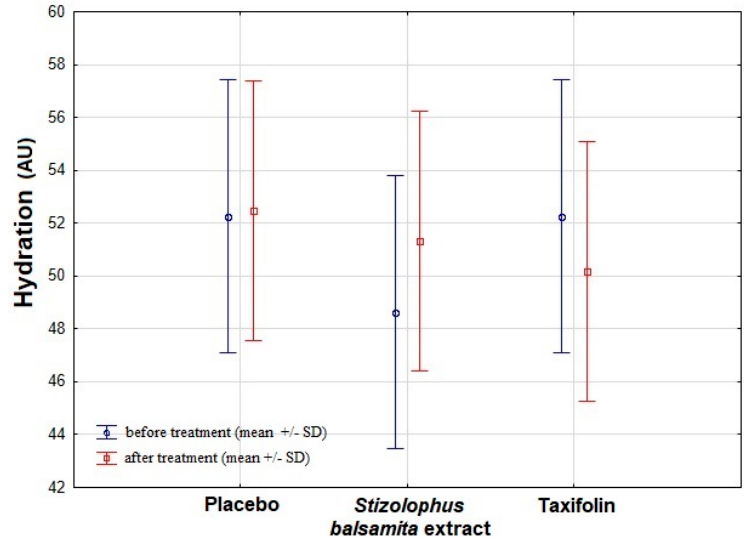
Figure 4. The comparison of skin hydration results between the examined groups. The results are expressed as mean ± standard deviation, SD ( p < 0.05). There was no significant difference between skin hydration measured before and after treatment in examined groups. Descriptions: AU—arbitrary unit.